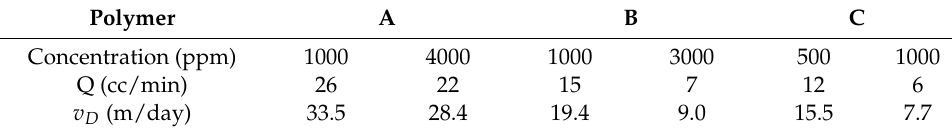
Figure 3. Polymer pretreatment processes. Table 2. Applied flow rates for presheared and reinjected polymer solutions.